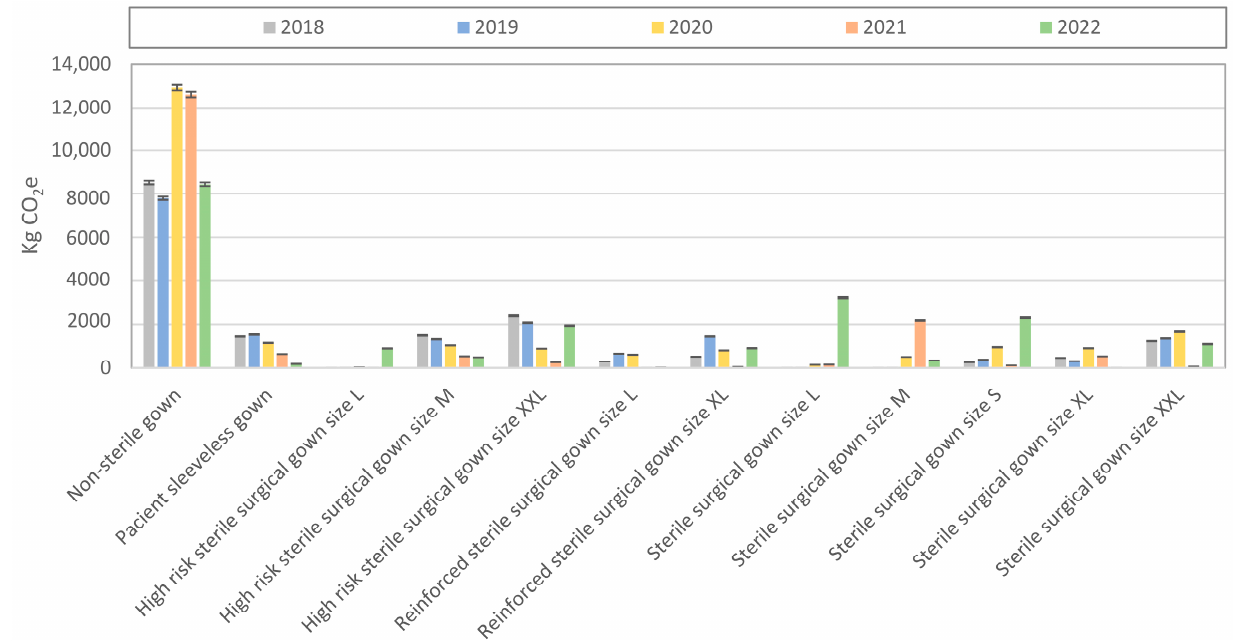
Figure 2. Annual carbon footprint of the total gown consumption per gown type.